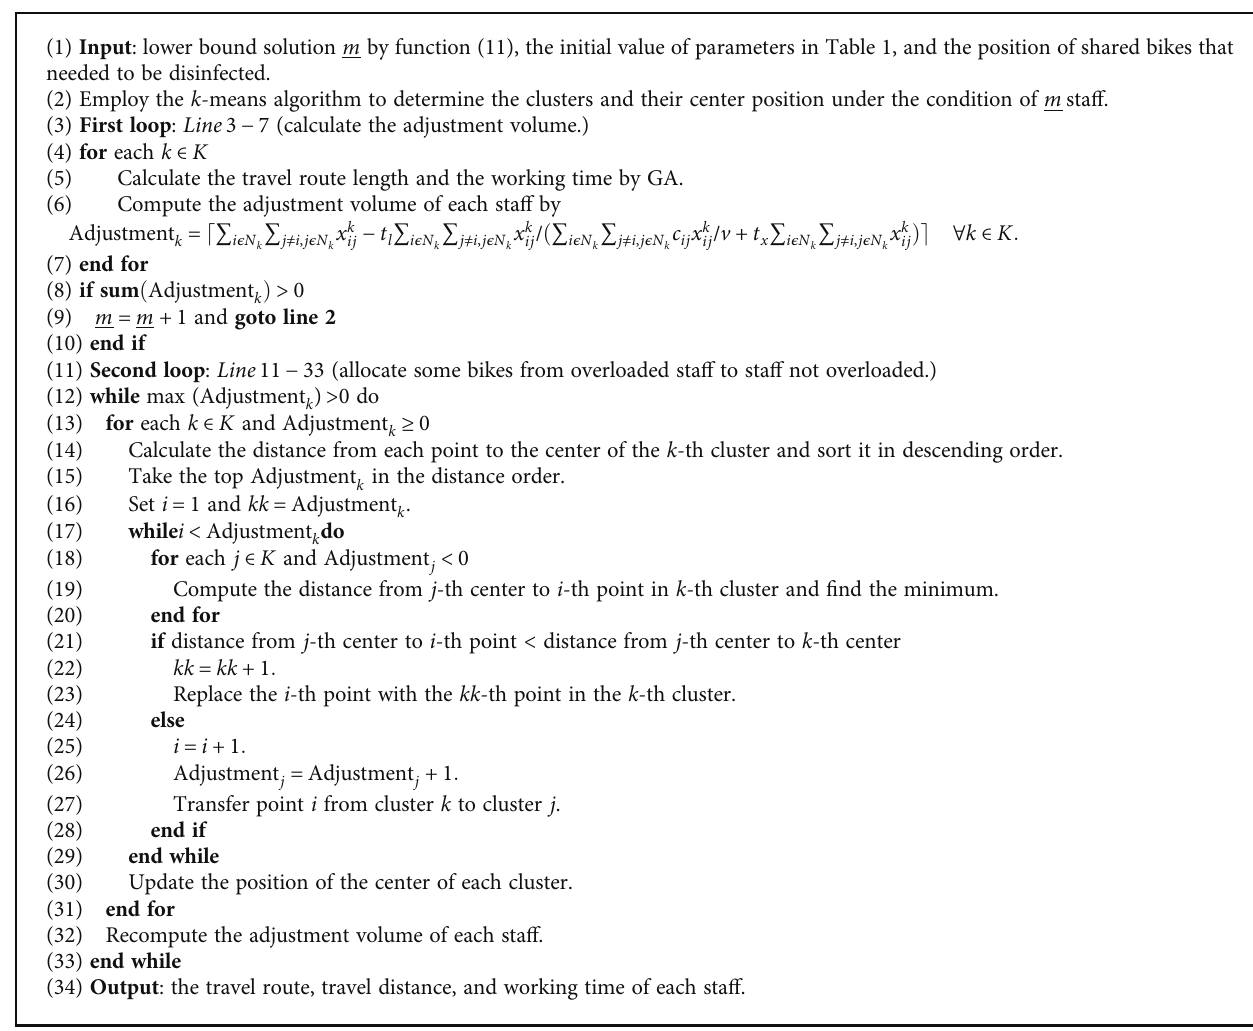
Algorithm 1: K-GA-adjustment